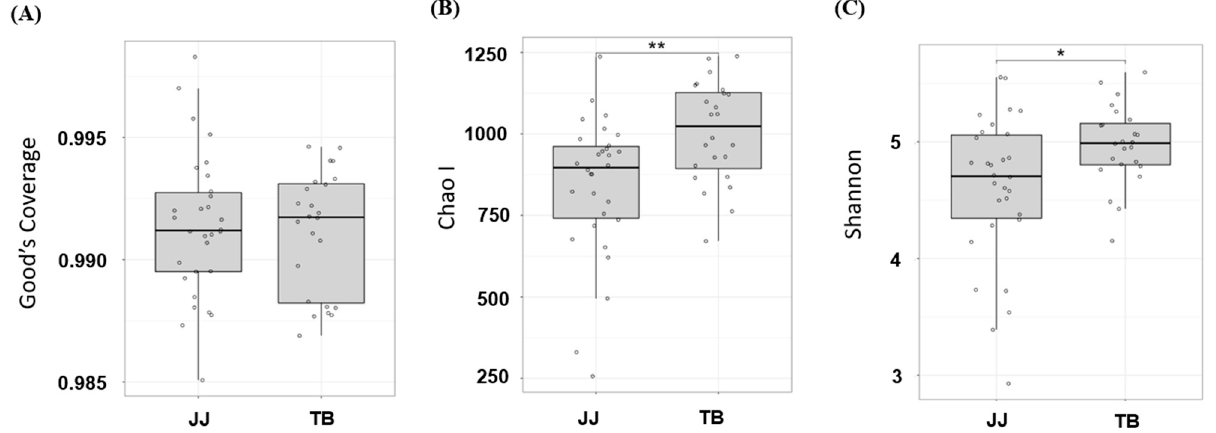
Figure 1. Ecological indices comparison, species richness comparison with Good’s coverage ( A ), Chao I ( B ), and species evenness Shannon ( C ); * and ** indicate p < 0.05 and p < 0.01 with the student’s T -test. JJ; Jeju horse, TB; Thoroughbred